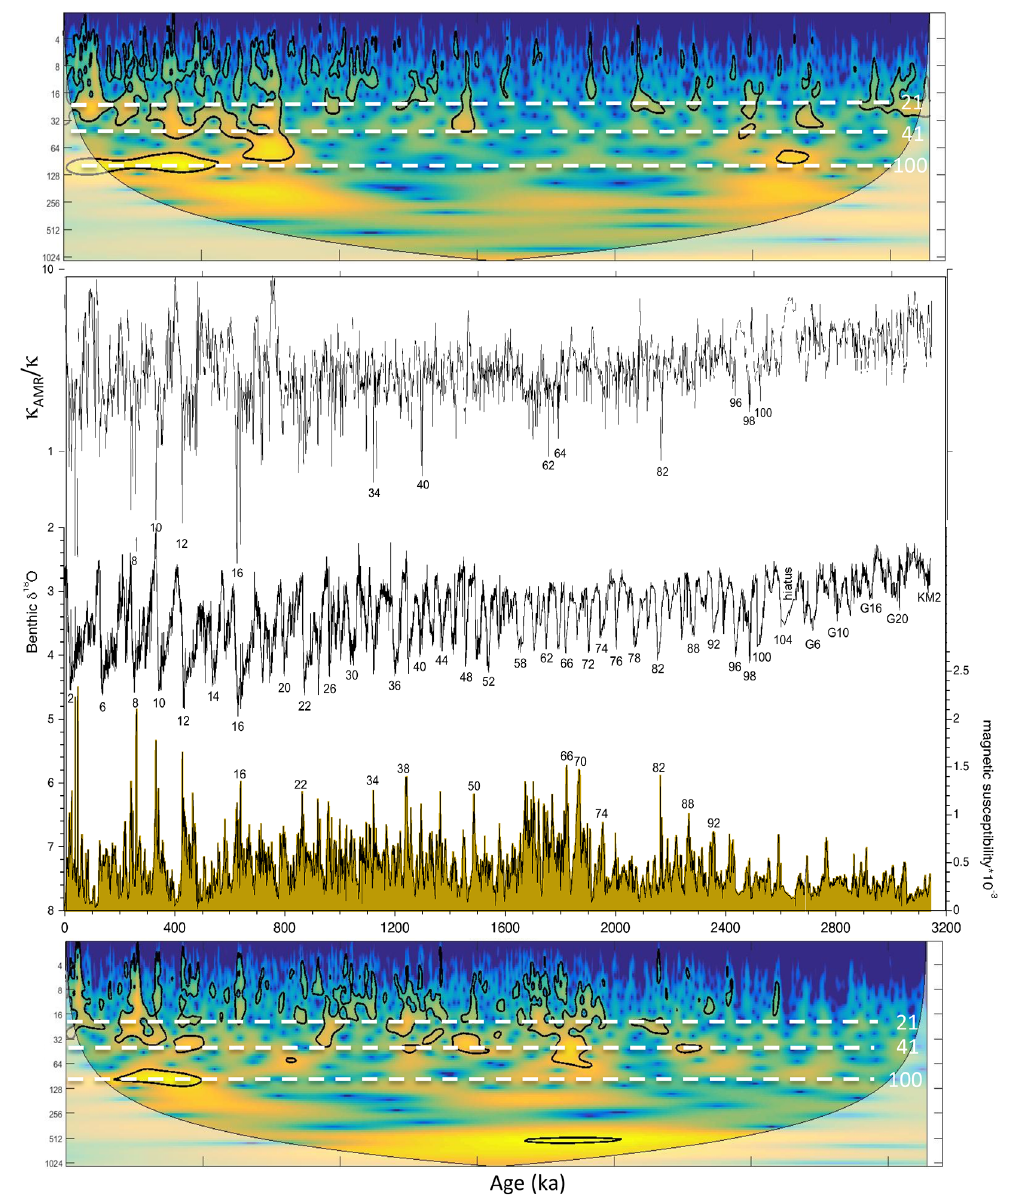
Figure 8. κ ARM /κ (proxy for magnetic grain size) and magnetic susceptibility (brown) relative to the benthic δ 18 O record of Site U1308. Prominent marine isotope stages are labeled. Top and bottom panels are continuous wavelet transform of the κ ARM /κ and magnetic suscep- tibility records of Site U1308, respectively. Black contour on the wavelet plots indicates the 5% significance level against red noise. The horizontal dashed white lines represent the orbital periods of precession ( ∼ 21kyr), obliquity ( ∼ 41kyr), and eccentricity ( ∼